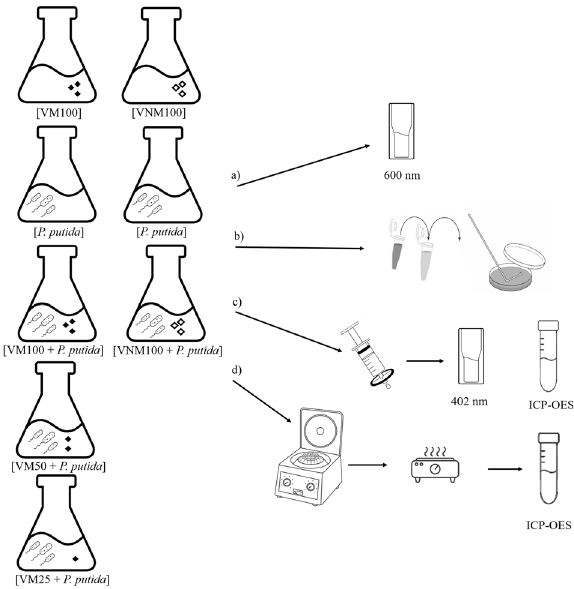
Fig. 1 Schematic experimental design of all the tested dissolution conditions and following analysis. a Optical Density at 600 nm, b plate counting by sequential dissolution, c UV-VIS absorption of the fi ltered leachates, and d analysis of the recovered bacterial pellets and cleaning